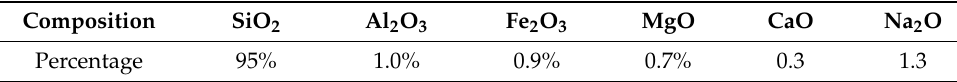
Table 3. Chemical compositions of the silica fume.